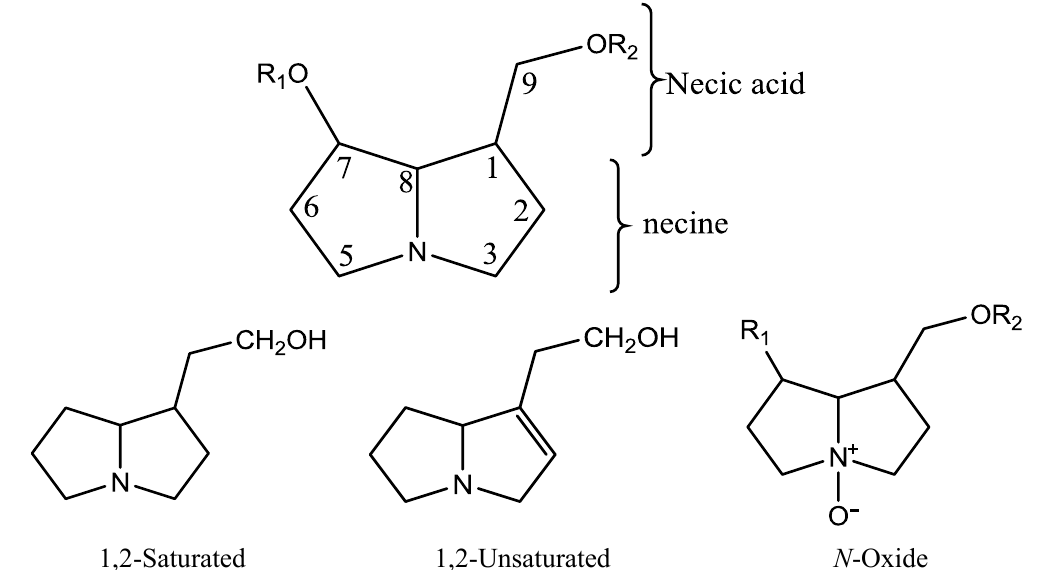
1,2-Saturated 1,2-Unsaturated N